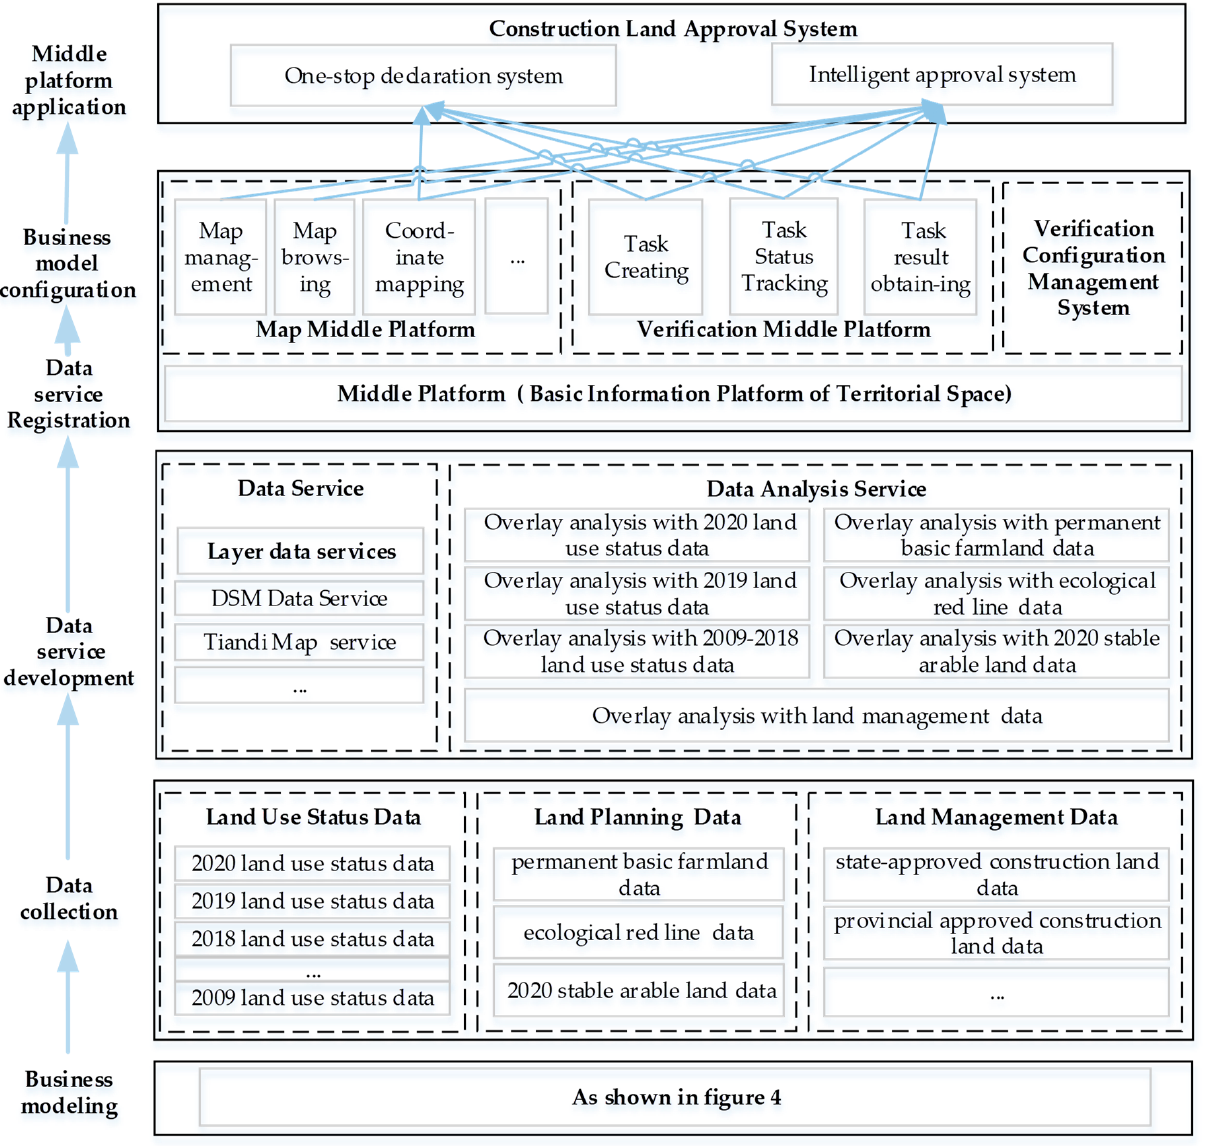
Figure 5. Developing process of construction land approval verification function based on middle platform.